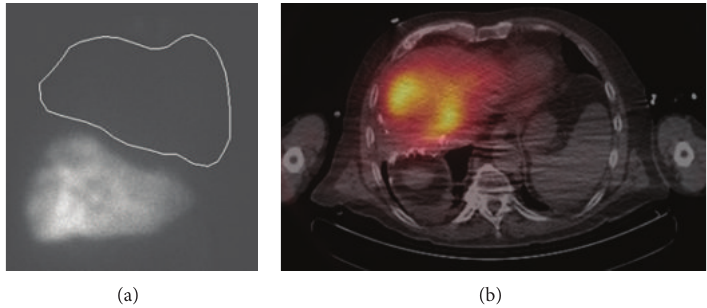
Figure 2: (a) Tc-99 MAA scintigraphy after pre-SIRT mapping demonstrated 6% lung shunting, within acceptable values ( < 20%). (b) Post- SIRT Bremsstrahlung SPECT/CT showed heterogeneous tracer distribution throughout the remaining left lobe of the liver. No extrahepatic shunting was seen.